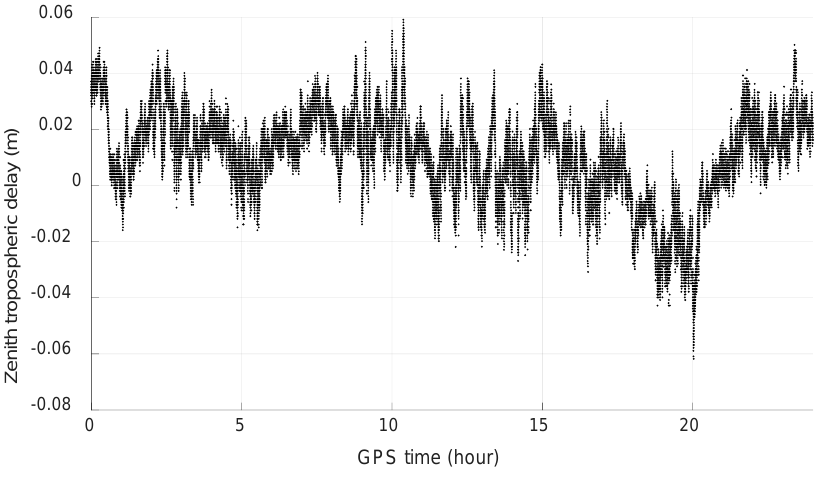
Figure 20. Estimated tropospheric error of CEBR-VILL (GPS).